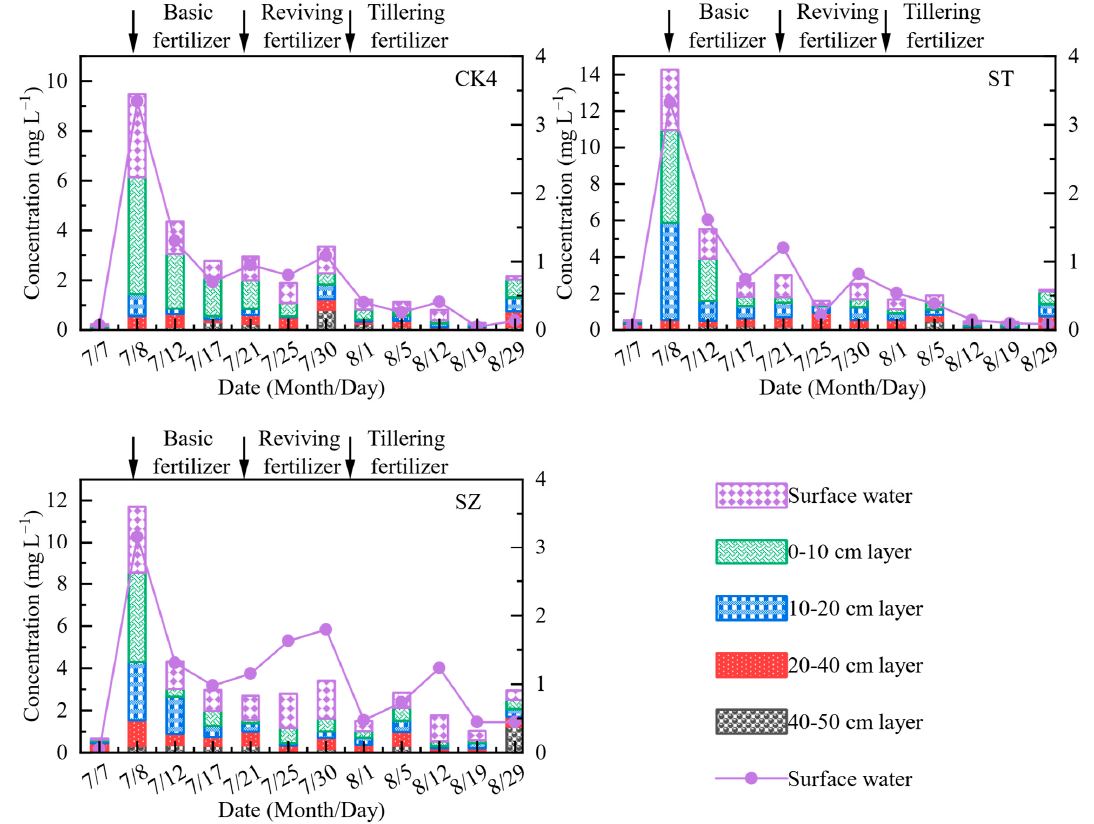
Figure 10. Dynamic changes in total phosphorous (TP) concentration in different layers of surface water and soil solutions under different treatments. Top left panel shows the no straw returning group (CK4); top right panel shows the straw returning group (ST); bottom left panel shows the straw returning with zeolite group (SZ). Different fertilizer treatments are indicated by black